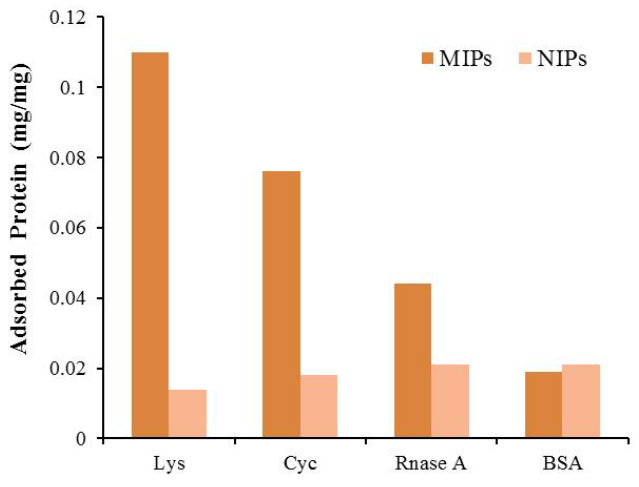
Figure 5. Comparison of different imprinted and non-imprinted polymers (NIP) to evaluate the adsorption selectivity for lysozyme (Lys), cytochrome C (Cyc), ribonuclease A (RNase A) and bovine serum albumin (BSA), respectively, at a concentration of 0.5 mg mL − 1 for all. Adopted from